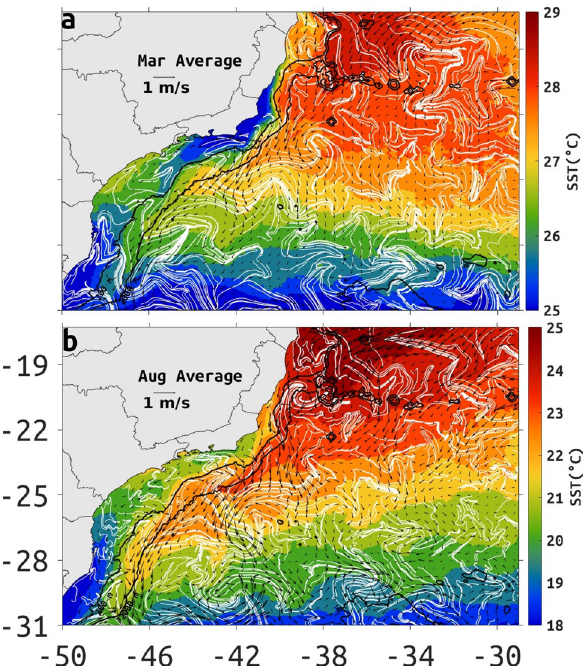
Figure 1. March ( a ) and August ( b ) monthly mean SST from the MUR dataset (color shading), with spatial resolution of 0.01 ◦ provided by PODAAC (Physical Oceanography Distributed Active Archive Center), superposed by the corresponding monthly-mean-surface ocean velocity from ROMS (black arrows) and cLCS (white lines). Depth contours of 200- and 2000-m are indicated in black lines. Note that color bars are different for each month. Created with Matlab R2018B (www.mathw